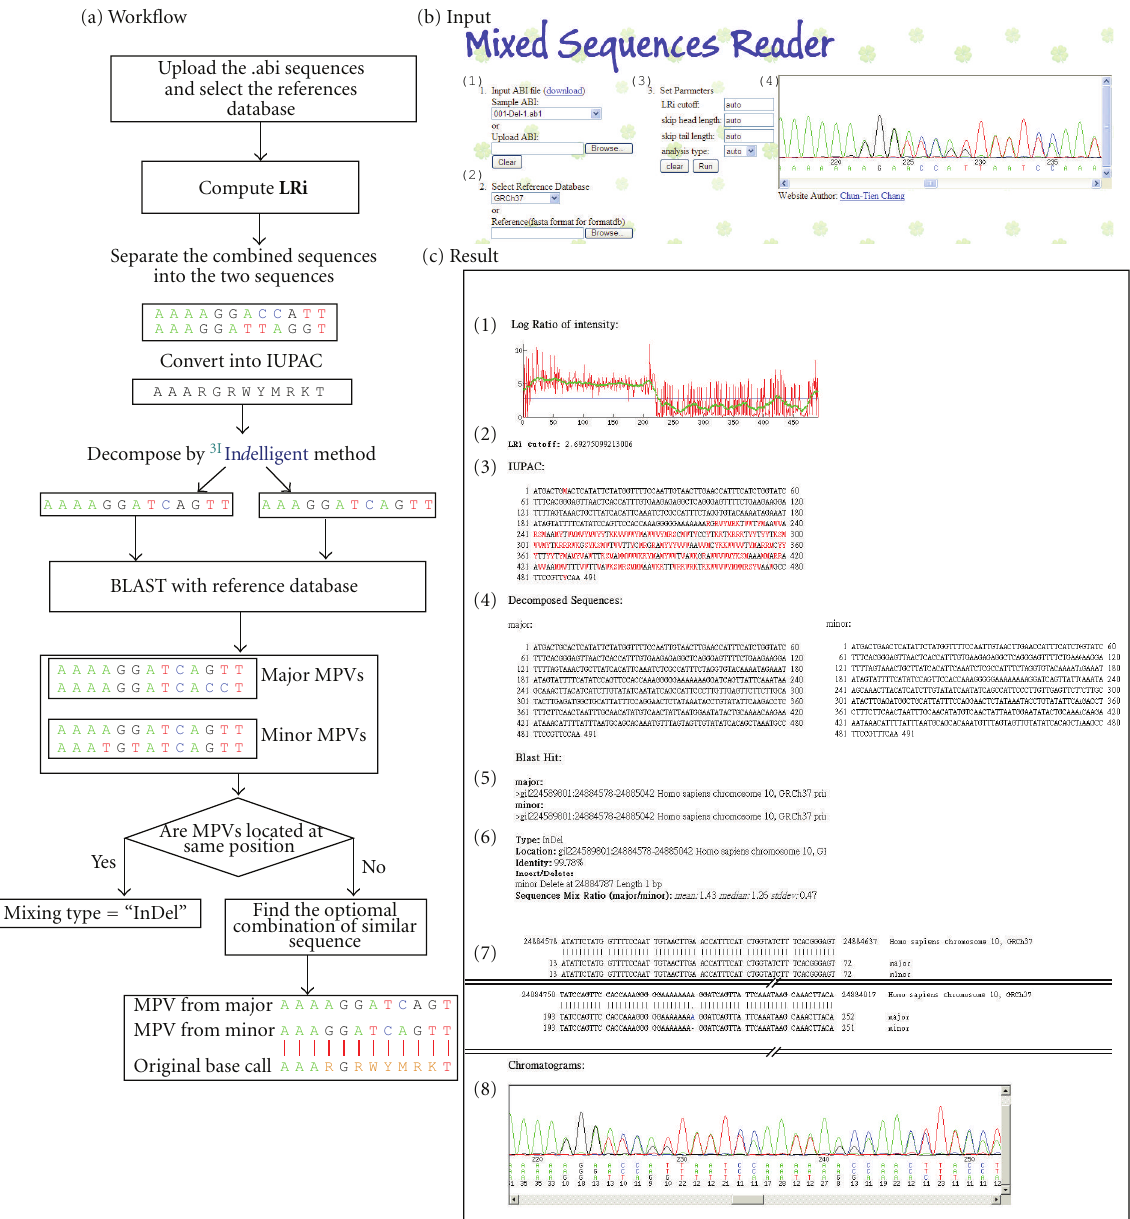
Figure 1: Workflow and user interfaces (input and result output) of the Mixed Sequences Reader (MSR). A flowchart describing the MSR workflow is shown in the left-side panel (a); the input interface of MSR is shown in the right-side panel (b); the result output is shown in panel (c). To input data, users can upload .abi sequences (b-1) and select the desired reference sequences (b-2). MSR defines an LRi (log ratio of intensity) value for each sequence as the log ratio of the two intensities of the combined signal peaks. On the basis of the smooth LRi curve (c-1), the LRi can be calculated (c-2); this value is used to separate the combined sequences into two sequences and then convert them into IUPAC code (c-3). The IUPAC codes are decomposed by In d elligent method into major and minor sequences (c-4). The major and minor sequences are BLASTed against a set of reference sequences to obtain the major and minor most possible variances (MPV) (c-5). If the MPVs are located at same position, the variant type is defined as an “indel”; if they are at di ff erent positions, the variant is defined as a “mixed” type (c-6). The variant type is then reported (c-7). The chromatographs of the analyzed sequences are shown in (b-4). The combination of major and minor sequences is shown in (c-8). Users have the option to define the LRi cut-o ff value, sequence type, and the ignored head and tail sequence lengths